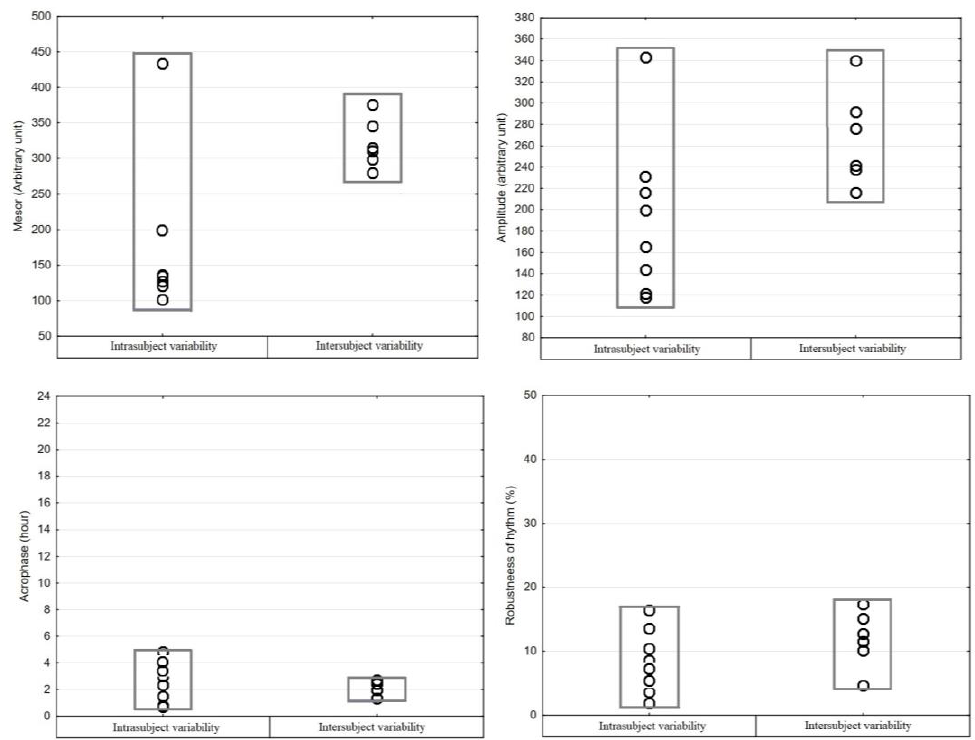
Figure 3. Results of the analysis of intra- and intersubject variability of the circadian parameters of the total locomotor activity rhythm recorded in eight calves for six consecutive days.